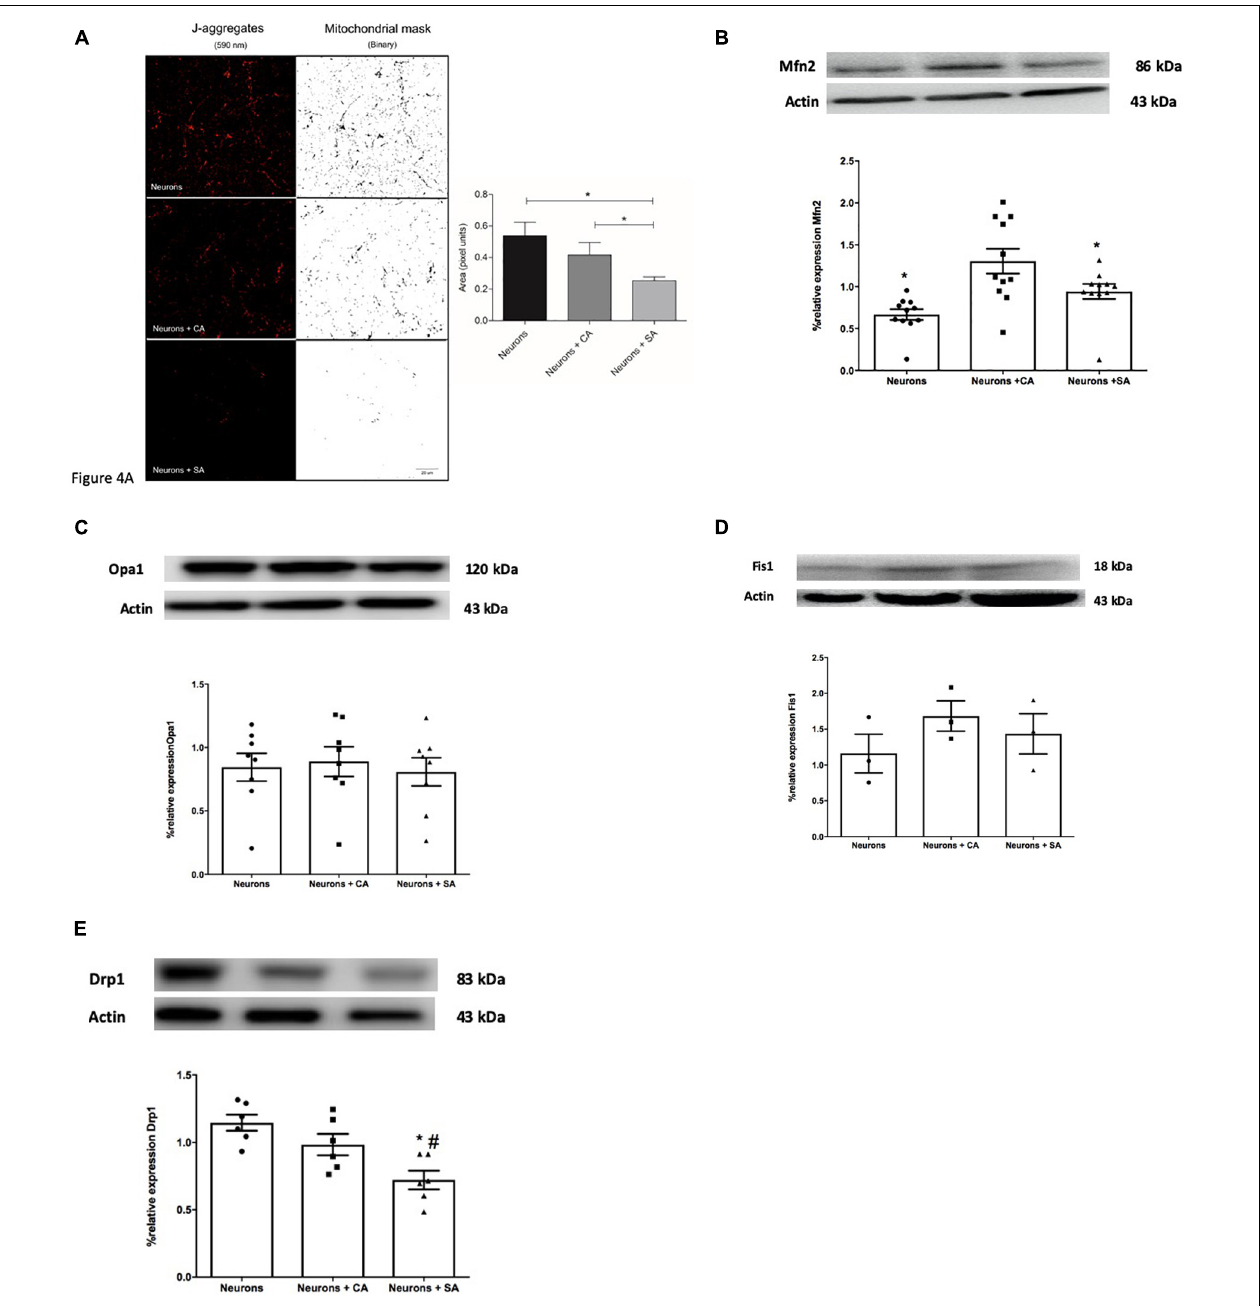
FIGURE 4 | Senescent astrocytes decrease the mitochondrial mass in primary cultures of cortical neurons and change mitochondrial dynamics. (A) Images show the J-aggregates (590 nm) corresponding to active mitochondria and their mitochondrial mask processed with the binary filter. Mitochondria mass analysis, performed in Fiji software, shows a significant decrease in the mitochondrial area corresponding to the neurons exposed SA. Mitochondrial mass analysis is expressed in pixels area and each column represents the mean ± SD of at least five areas of four independent experiments. * p ≤ 0.05. Scale bar = 20 µ m. (B–E) Mitochondrial dynamics-related proteins were evaluated by Western blot on neurons lysates as described in the methodology. Each bar represents the mean ± SE of three independent experiments. Statistical significance was tested by the ANOVA with respect to neurons group # p ≤ 0.05 and neurons + CA group. * p ≤ 0.05. Representative images of the blot and densitometric analysis for (B) Mfn2, (C) total OPA1, (D) Fis1, and (E)